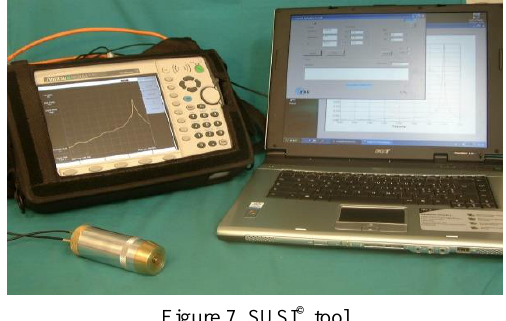
Figure 7. SUSI © tool